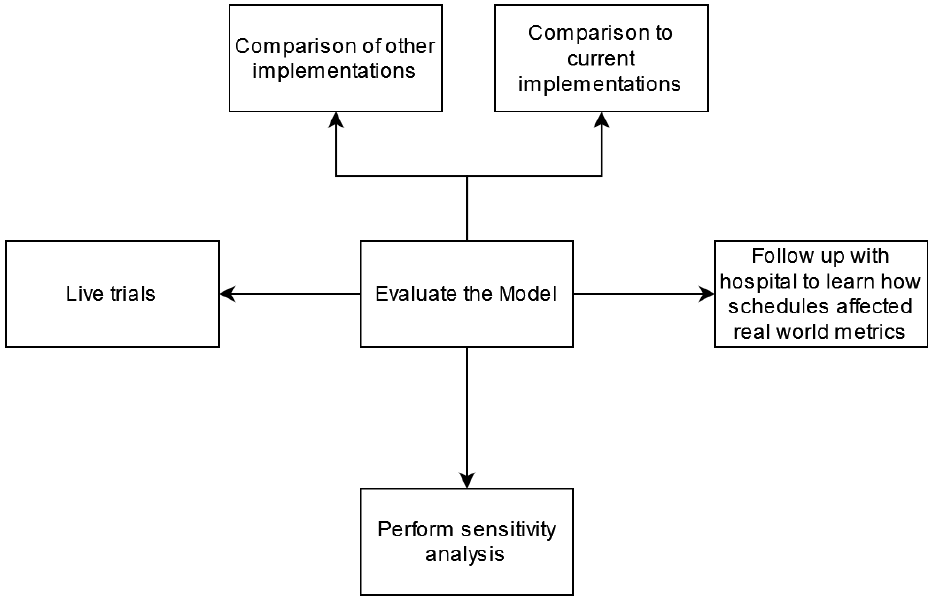
Figure 5. A flowchart of decisions to be made when evaluating the outputs of your